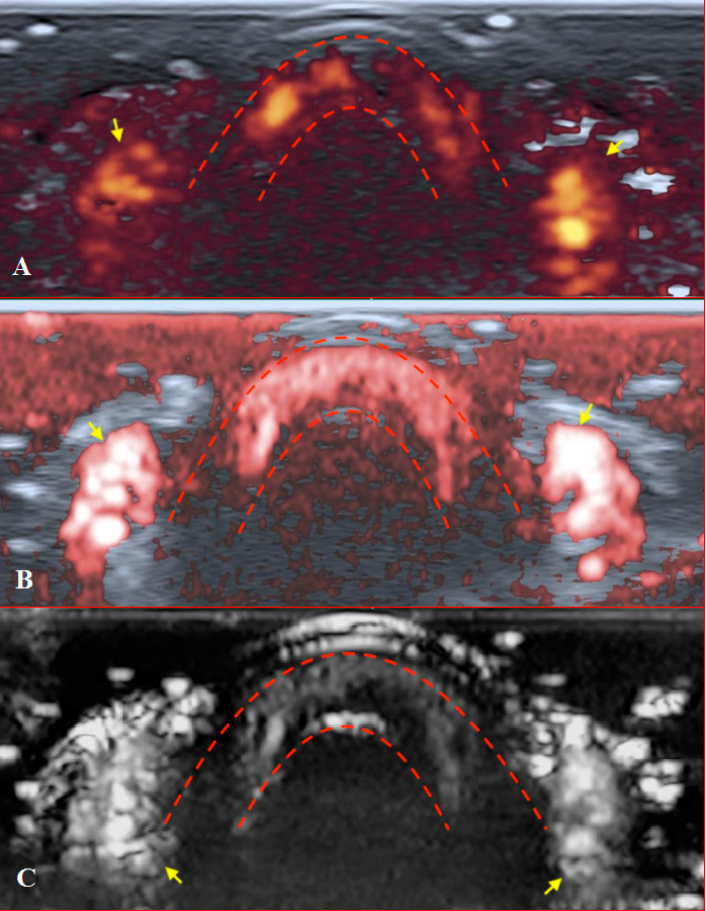
Figure 7. Transverse scans of a healthy fingertip with high gain: ( A ) PD; ( B ) cSMI; ( C ) mSMI. Red dotted lines define the zone between the nail and the surface of a distal phalanx. Yellow arrows mark the lateral nailfold.